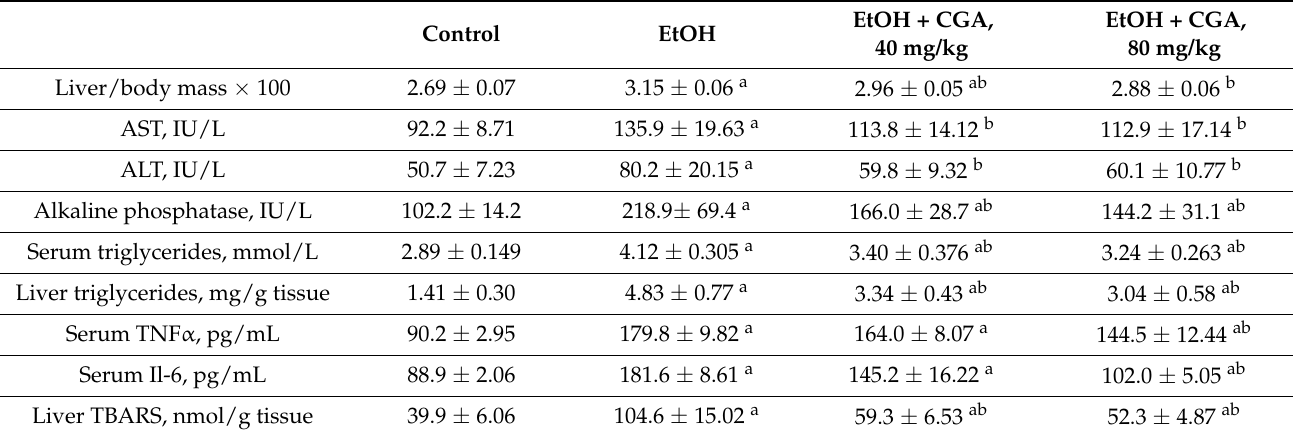
Table 2. Liver/body mass and serum and liver biochemical parameters in alcohol-fed rats (EtOH) administered with chlorogenic acid